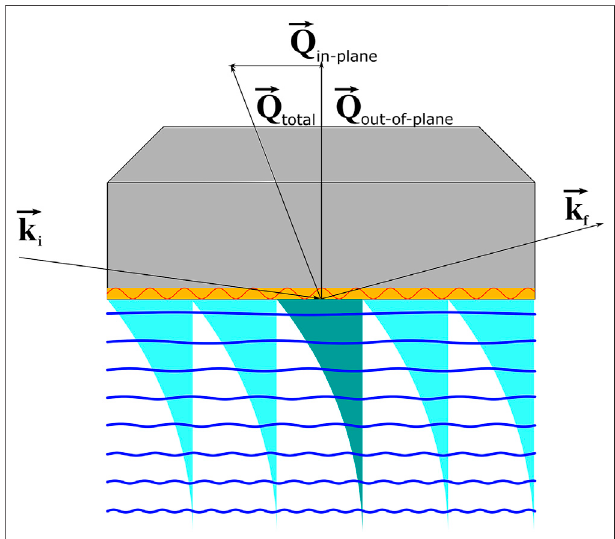
FIGURE1| Sketchoftheappliedscatteringgeometry:Forre fl ectometry the incoming wavevector k i and outgoing wavevector k f are identical. Hence, the total scattering vector Q is an out-of-plane vector perpendicular to the sample surface. For GISANS, a range of scattering angles are collected on the detector and therefore there are both in and out-of-plane components of the Q-vector, depending on the position on the detector. In case of the GINSES measurement, k i and k f are strictly different (incoming angle 0.2 ° , outgoing angle 8 ° ) which leads to an in-plane component of Q in-plane (cid:1) 0.0072 Å − 1 . However, since the active detector area of 10 cm width at 4 m sample detector distance is involved into data collection the uncertainty of outgoing angle is 0.25 mrad, which results in the uncertainty described in the